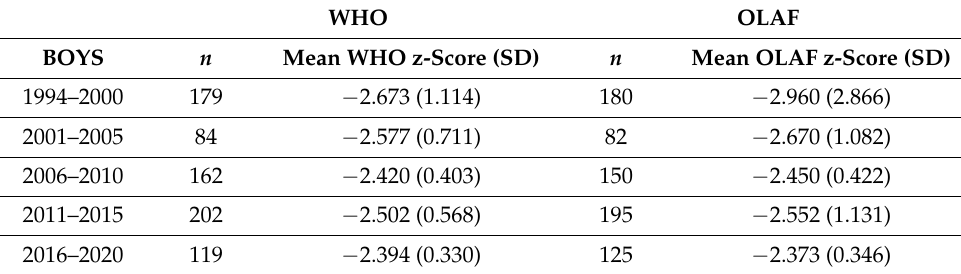
Table 3. Mean z-score in underweight boys by year of study and methods. WHO